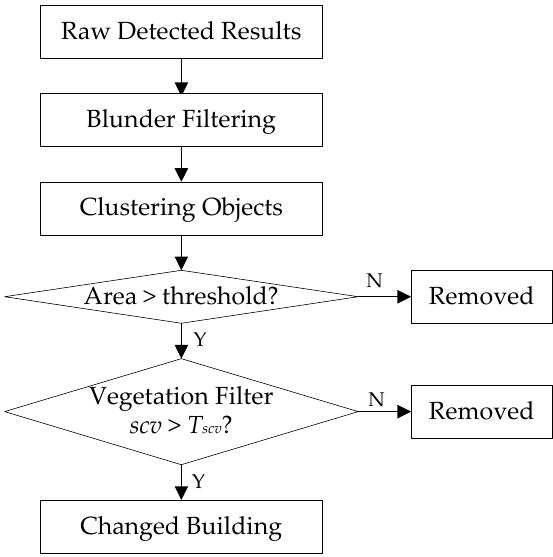
Figure 5. The workflow of positive building change results refinement.